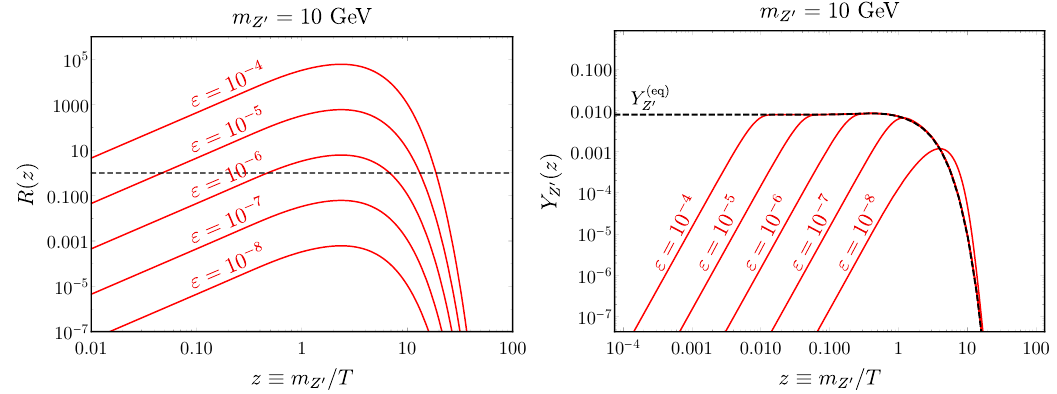
Figure 2 . Dimensionless production rate induced by inverse-decay de(cid:12)ned in eq. (4.9) on the left and numerical solution of the Boltzmann equation of eq. (4.7) on the right for a given set of